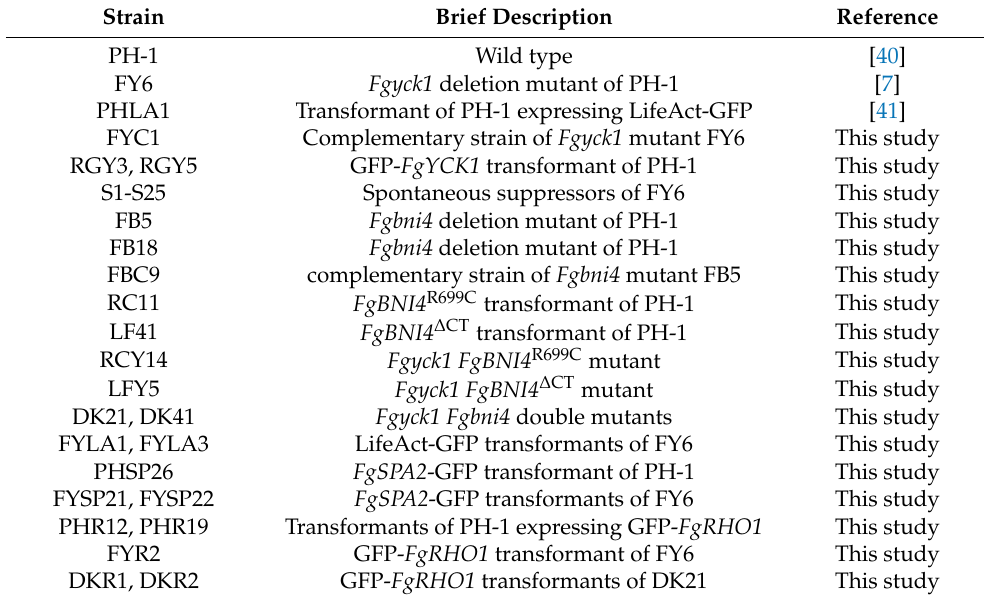
Table 1. Strains of Fusarium graminearum used in this study.